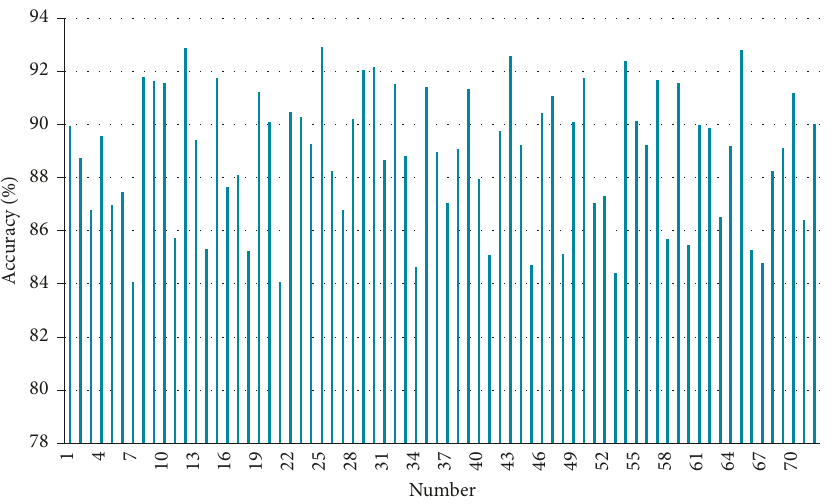
Figure 9: Statistical chart of the accuracy of model